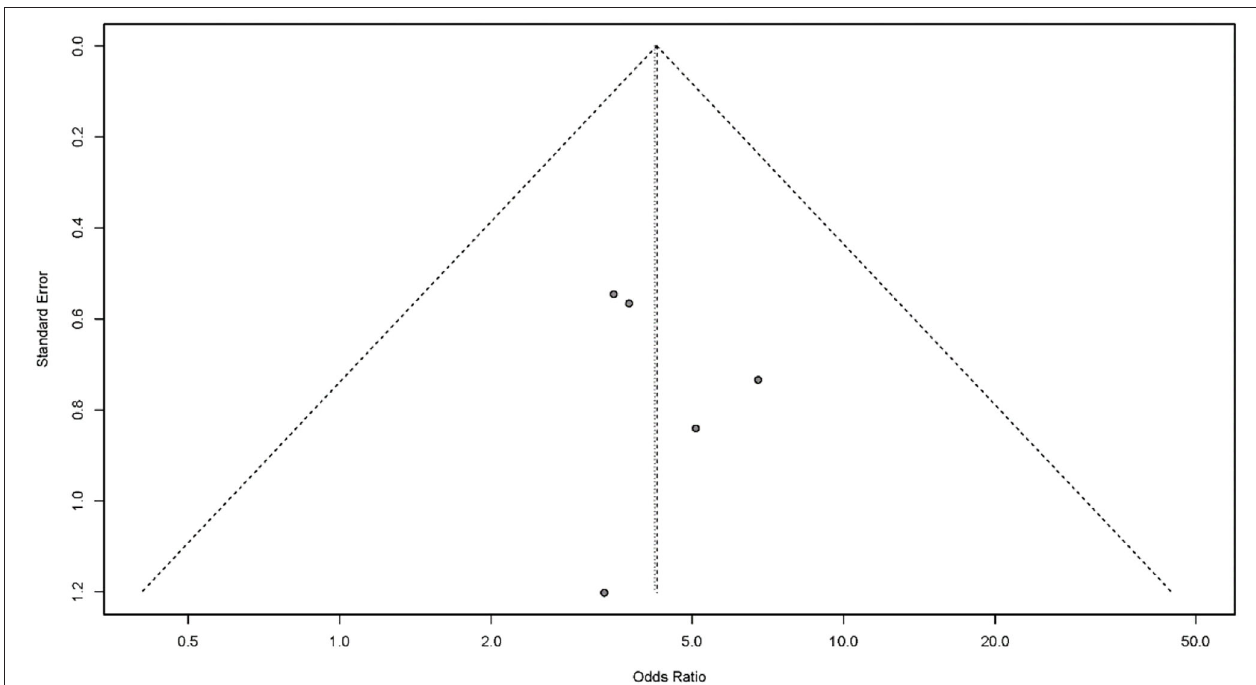
FIGURE 6 | Funnel plots for the assessment of publication